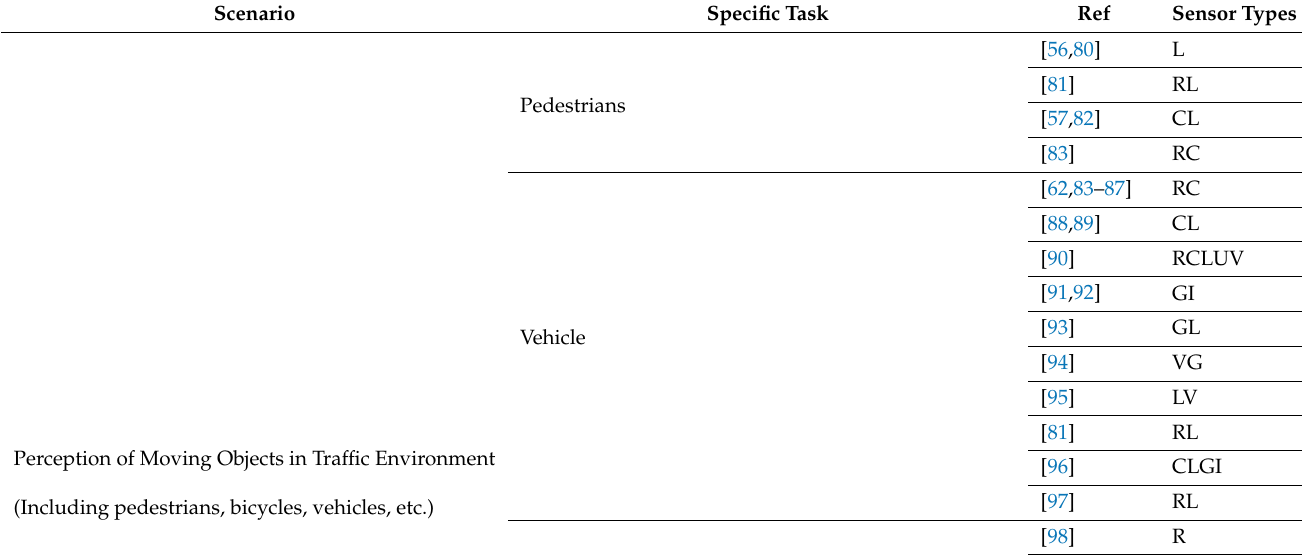
Table 3. Task analysis based on sensor